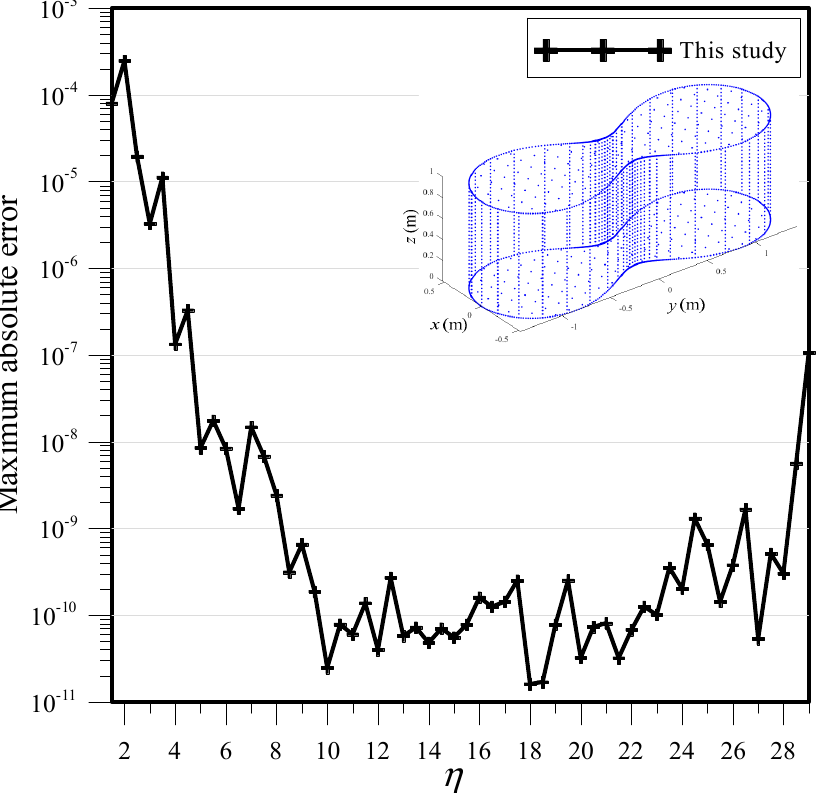
Figure 4. Maximum absolute error (MAE) versus the order of η .